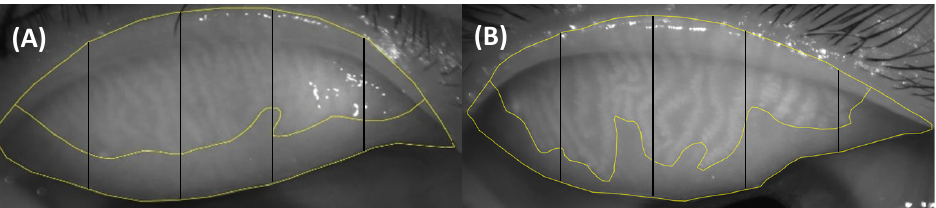
Figure 3. The different UAS between the two meibography images of similar meibograde (meibograde = 1). ( A ) showed the UAS (UAS = 0) of the upper eyelid in the Demodex -negative MGD group, and ( B ) showed the UAS (UAS = 3) of the upper eyelid in the Demodex -positive MGD group.